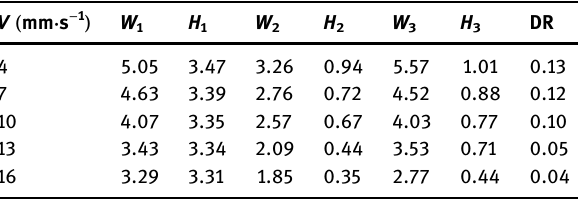
Table 2: The values of geometric characteristics at di ff erent scan - ning speed